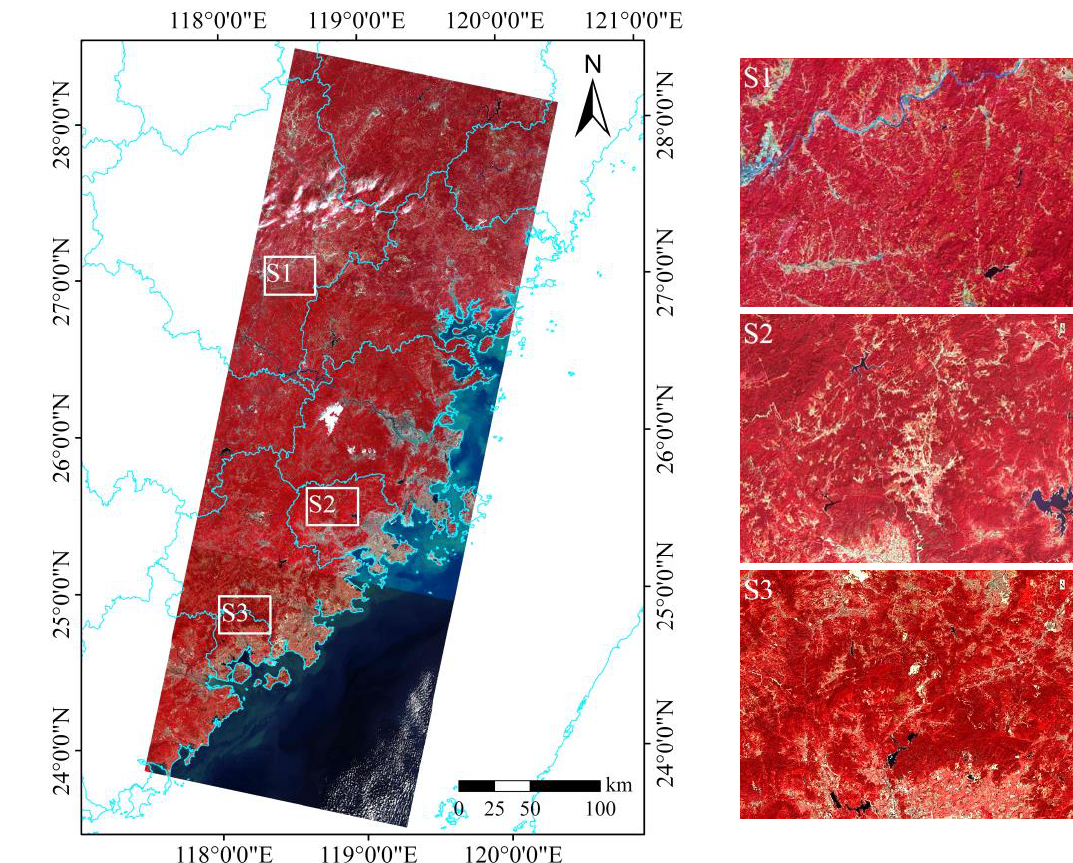
Figure 7. Images of three scenes and the corresponding clipped subareas (NRG composite). Coupled with the 213 sets of samples in Path 119/Row 042, 255 sets of samples in Path 119/Row 041 and 98 sets of samples in Path 119/Row 043 were selected, respectively (Figure 1). Using these 566 sets of evaluation samples, the scatter plots of waveband reflectance vs. cos i showed that the self-shadow (black) was located where the cos i was less than 0.0, while the remaining types of samples were distributed in the area where the cos i ranged from 0.0 to 1.0, with the sequence of self-shadow (black) < cast shadow (blue) < sunny area (green) (Figure 8). The ITC-corrected reflectance of RGB and NIR in the shadow area was approximately similar to that in sunny area, the linear regression showed an inclination that nearly reached the horizontal, and the r 2 decreased to 0.00~0.01. It was also found that the points were distributed in a concentrated way, evenly on both sides of the regression line (Figure 8c,f,i,l). However, before topographic correction, the surface reflectance of the shadows was lower than that of the sunny areas. Accordingly, the linear regression showed a steep inclination and a low intercept, with r 2 more than 0.43 (Figure 8a,d,g,j). As for the SCS + C-corrected result, the reflectance of the self-shadow was rectified better than that of the cast shadow and was closer to that of the sunny area. The linear regression showed a medium inclination and intercept, with r 2 ranging from 0.01 to 0.20 (Figure 8b,e,h,k). The relative errors in reflectance of the shadow area vs. the sunny area are illustrated using a histogram in Figure 9. The absolute relative errors of the cast shadow and the self-shadow after the correction using the ITC all dramatically decreased to the range of 0.30%~6.37%. As a contrast, these relative errors were large before topographic correction, varying from 68.46% to 86.34%; meanwhile, the relative errors of the SCS + C-corrected values just decreased to the range of 16.38% to